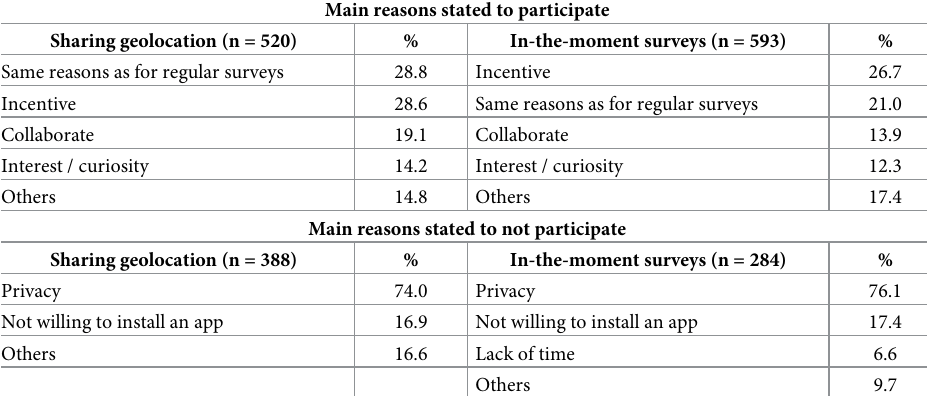
Table 5. Main reasons to participate or not in geolocation-based research